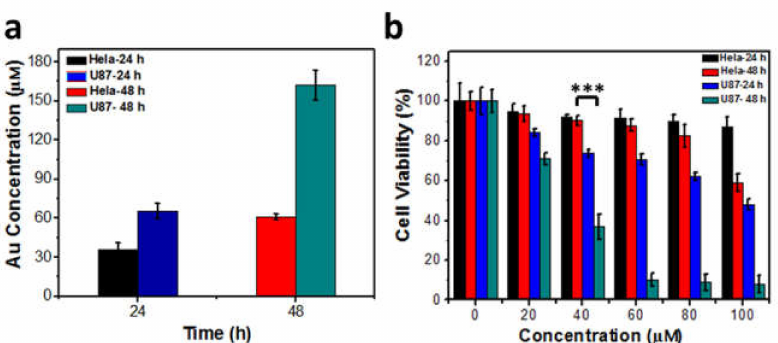
Figure 4. ( a ) Single cell AuCs quantitative analysis in the case that cells were incubated with 40 µ M AuCs for 24 and 48 h, n = 3 for each group. There is no significant difference of gold content in U87-MG cells treated for 24 h and HeLa cells treated for 48 h; ( b ) The cell toxicity of tumor cells treated with a series of concentration of AuCs for 24 and 48 h. Significant difference is observed between U87-MG cells treated with 40 µ M AuCs for 24 h and HeLa cells treated with 40 µ M AuCs for 48 h, *** p <